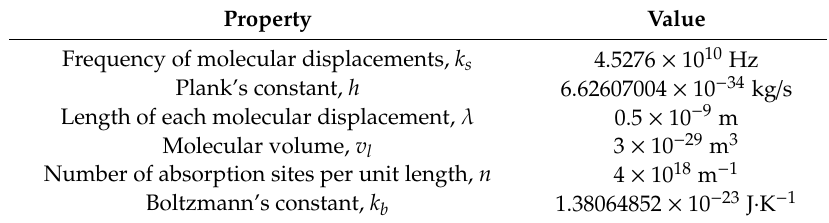
Table 1. Parameter values used in the dynamic contact angle calculation (Equation